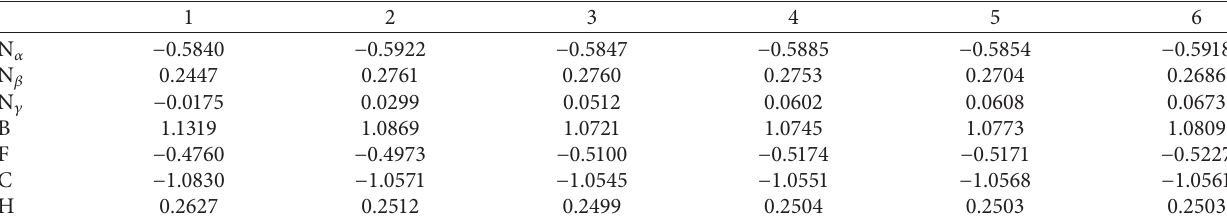
Table 2: Atomic charge (e) of the most stable structure (CH